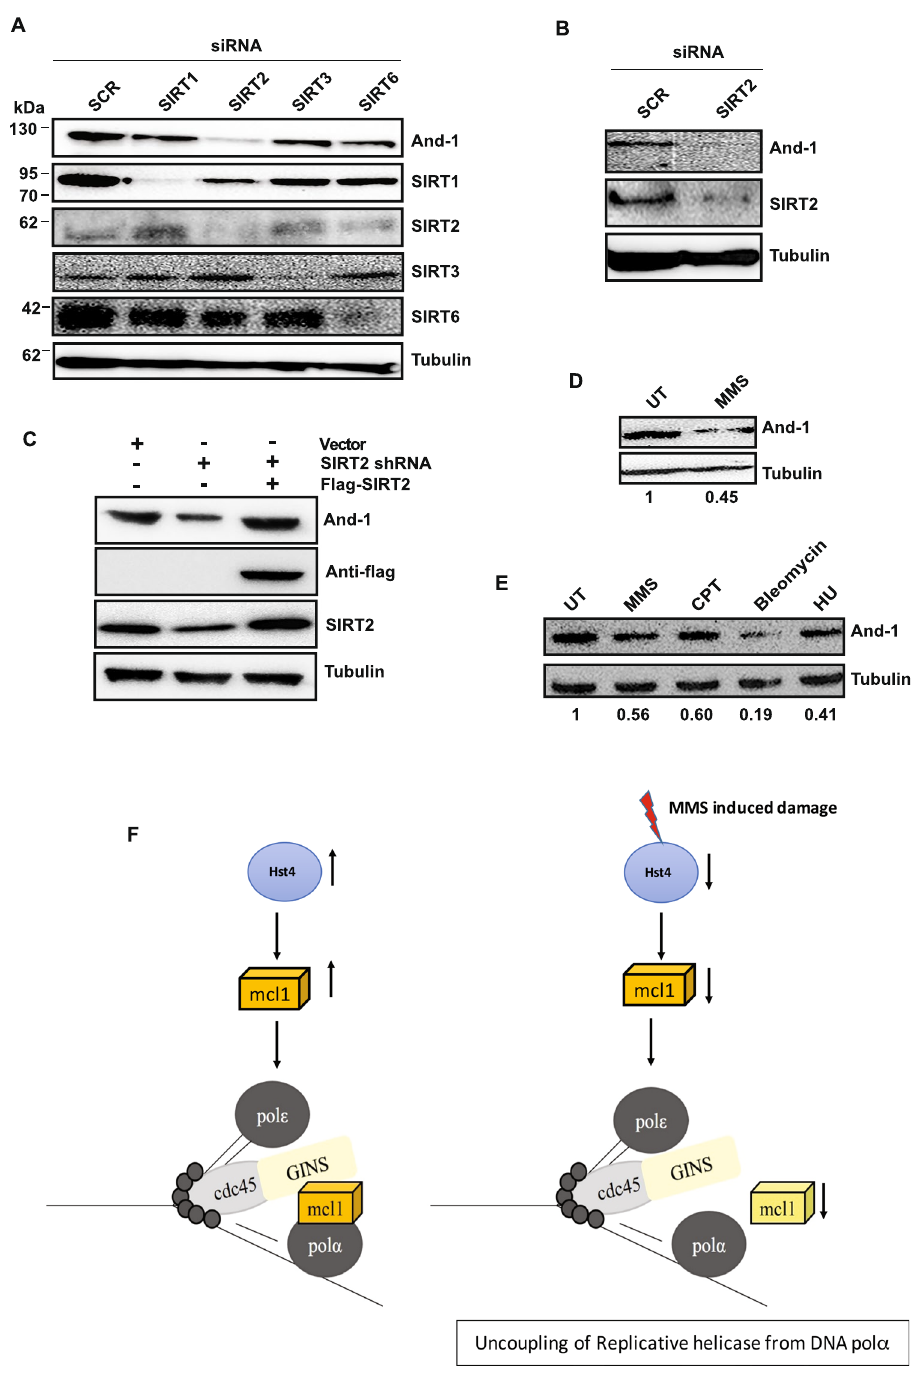
Figure 8. Human Sirtuin2 regulates Mcl1/And-1 expression. ( A ) HeLa cells were transfected with scramble, SIRT1, SIRT2, SIRT3 and SIRT6 siRNA. At 48 h post transfection, whole cell extracts were prepared and And-1 expression was detected by Western blot. The expression of indicated sirtuins was detected by respective antibodies. ( B ) Western blot showing depletion of hSIRT2 reduces And-1 expression. ( C ) HeLa cells were transfected with SIRT2 shRNA targeted to 3 ′ end of endogenous mRNA for 48 h and then transfected with Flag-SIRT2 for 24 h. Whole cell lysates were analyzed for indicated proteins by Western blot ( D ) Western blot showing And-1 expression in cell lysates from HeLa cells untreated or treated with 0.005% MMS. ( E ) Western blot showing And-1 expression in HeLa cells treated with indicated damaging agents. The amount of And-1 was quantitated relative to tubulin. The average relative intensity of bands is from three independent experiments. ( F ) Model showing how decrease in Mcl1 level mediated by down regulation of Hst4 may cause stalling of replication fork to preserve genomic integrity. In wild-type cells, Mcl1 couples replicative helicase and polymerase leading to efficient DNA synthesis. Under replicative stress such as MMS, Hst4 is down regulated resulting in decrease in level of Mcl1 causing uncoupling and stalling of replication fork to prevent DNA